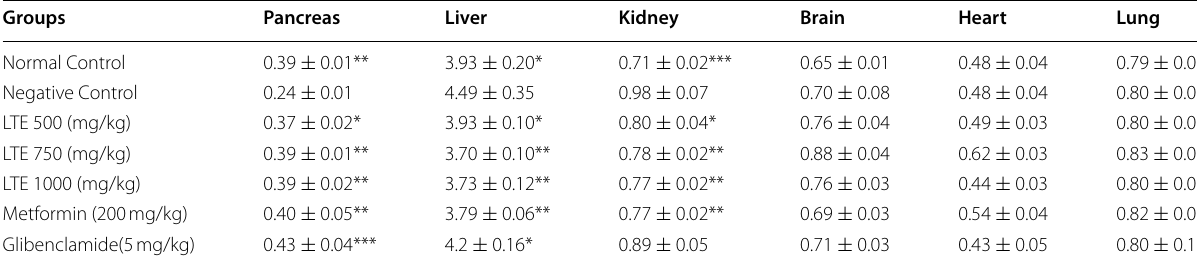
KEY: Values in the table represent the means comparisons test. * represents statistical significance vs. the negative control group at p ˂ 0.05